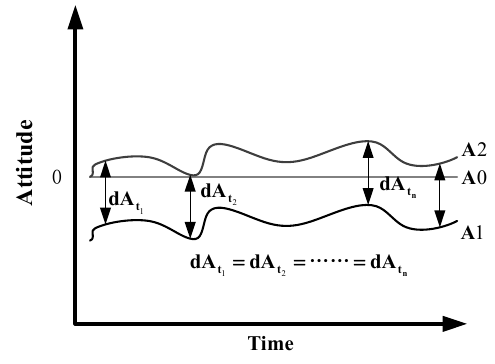
Figure 7. Schematic of relative attitude.